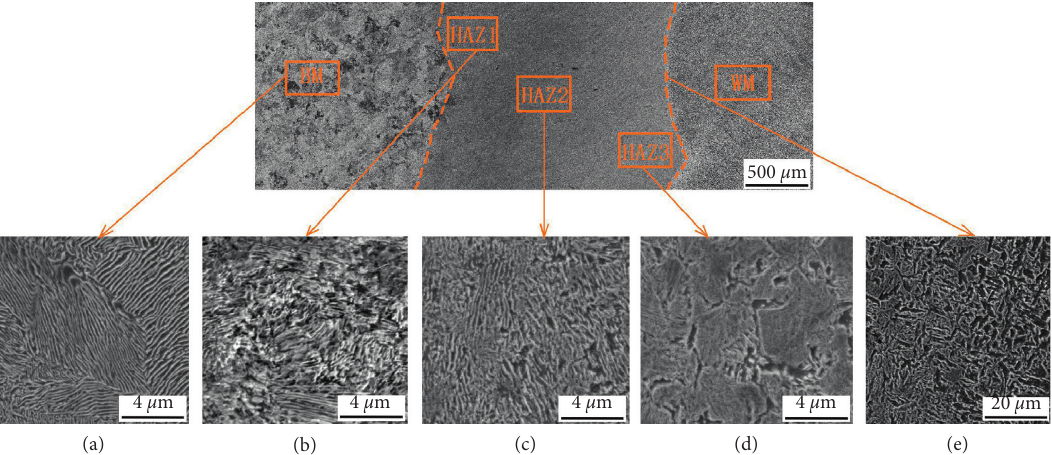
Figure 4: Microstructure of ultranarrow gap weld metals jointed: (a) base metal, (b) incomplete recrystallized zone, (c) recrystallized zone, (d) overheated zone, and (e) fusion